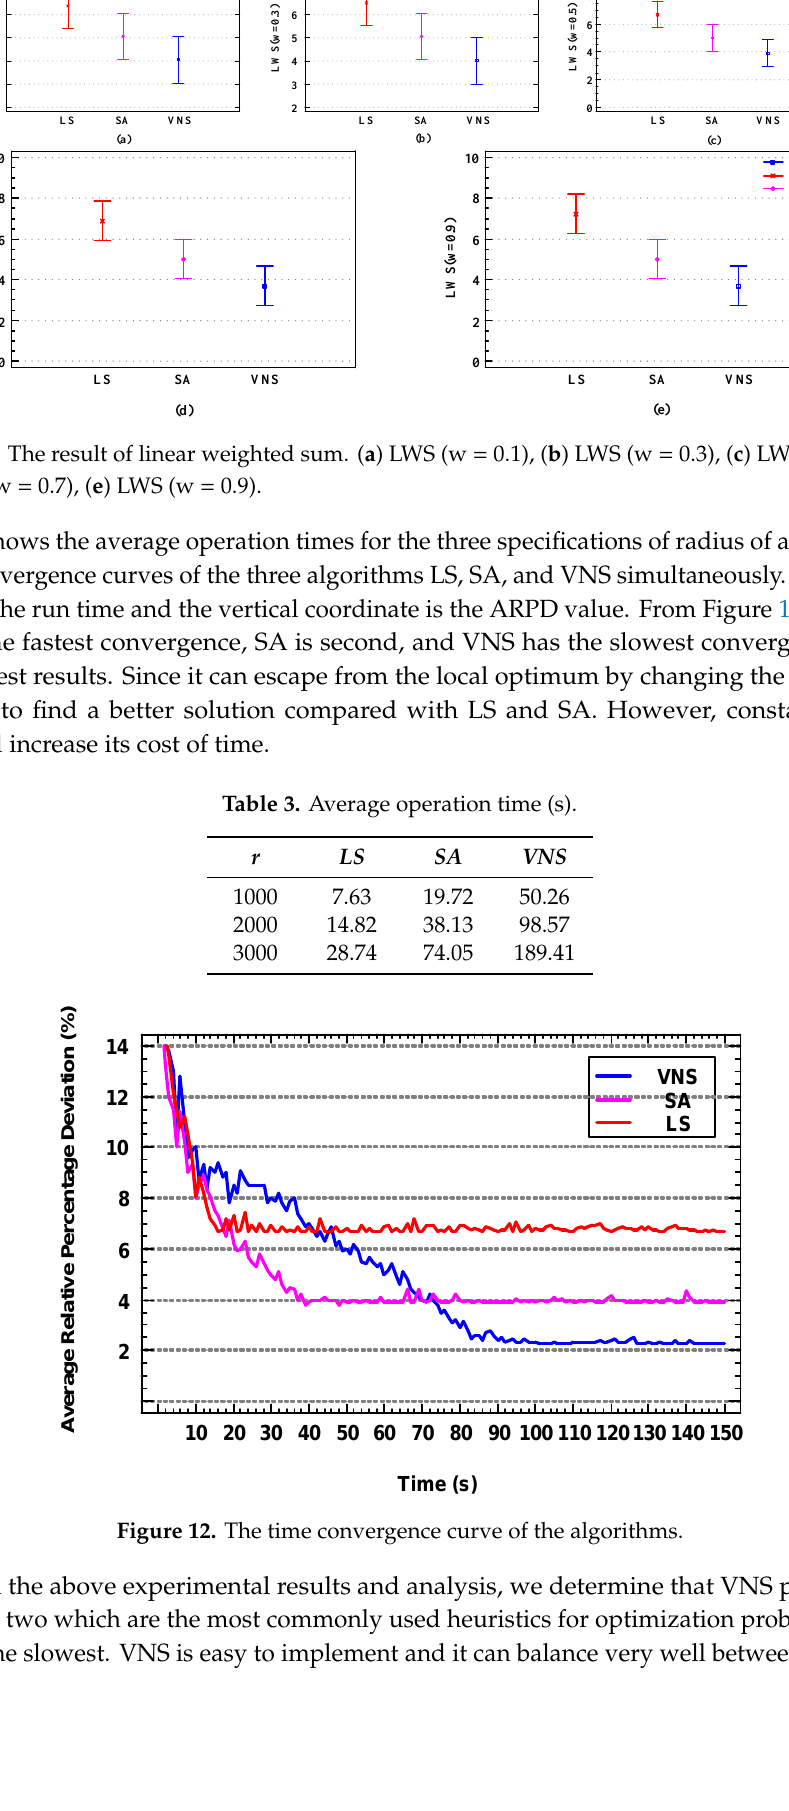
Figure 12. The time convergence curve of the algorithms.